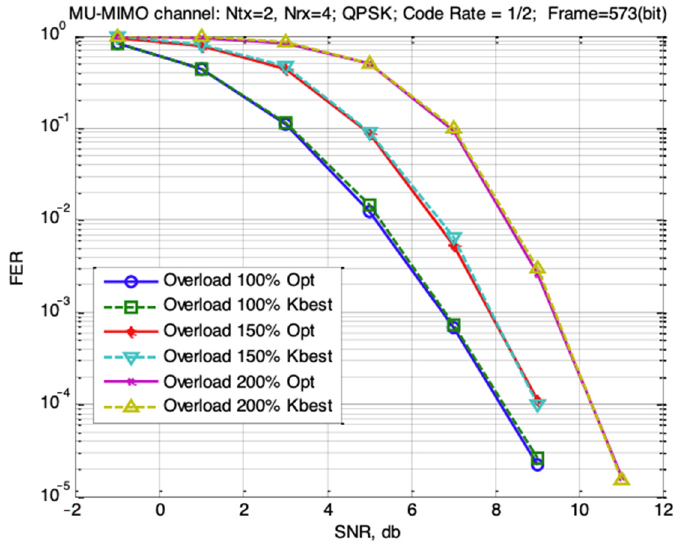
Figure 5. Dependencies of FER from SNR for the MU-MIMO uplink system with different numbers of users using FEC in overload mode.